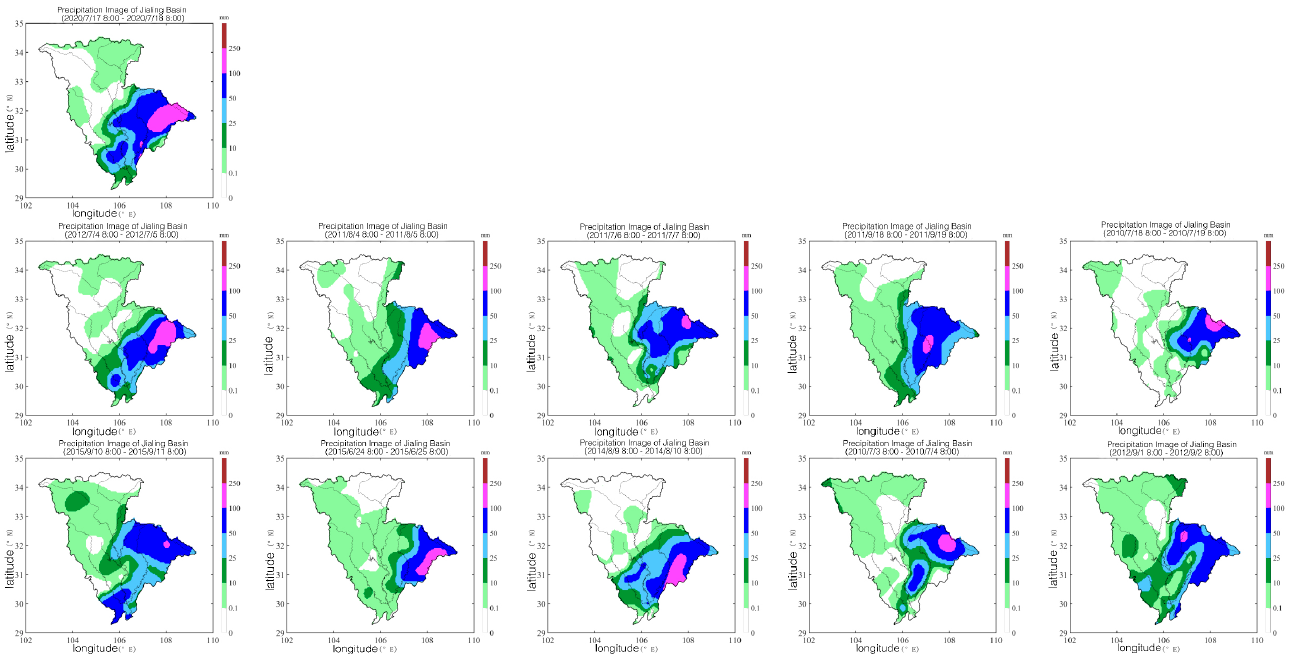
Figure 7. Image search results of NDCG-IPSO.